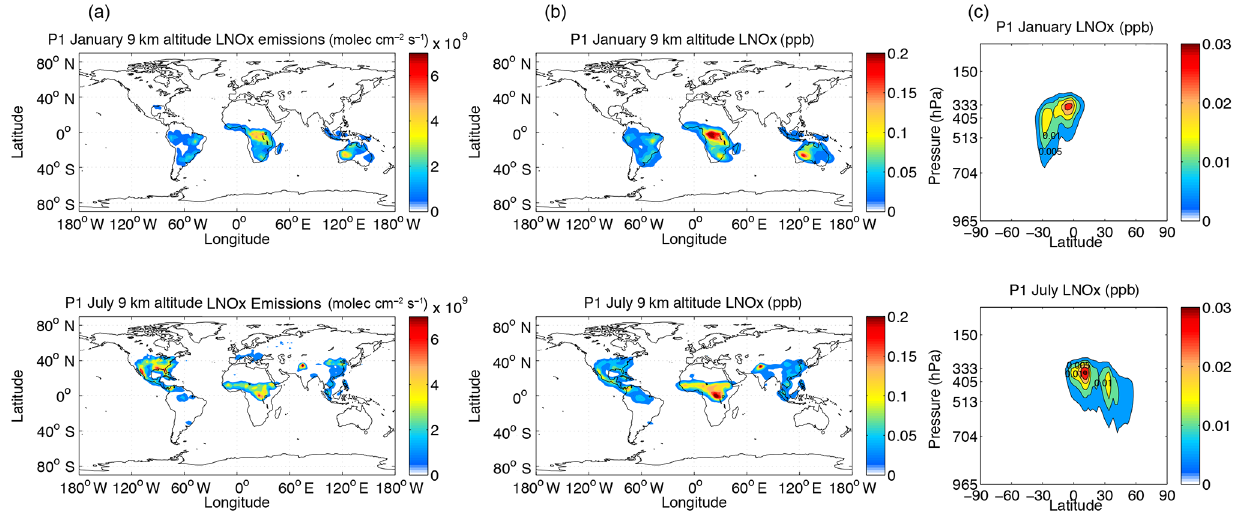
Figure 3. Geographical distributions at 9km altitude of lightning NO x emissions (left column, a ), the geographical distributions of the related LNO x tracer (in ppb; middle column, b ), and the zonal average of the LNO x tracer (in ppb; right column, c ) for January (top) and July (bottom). Experiment P1, using τ and K eff determined with D h = 15m 2 s − 1 and NO mean